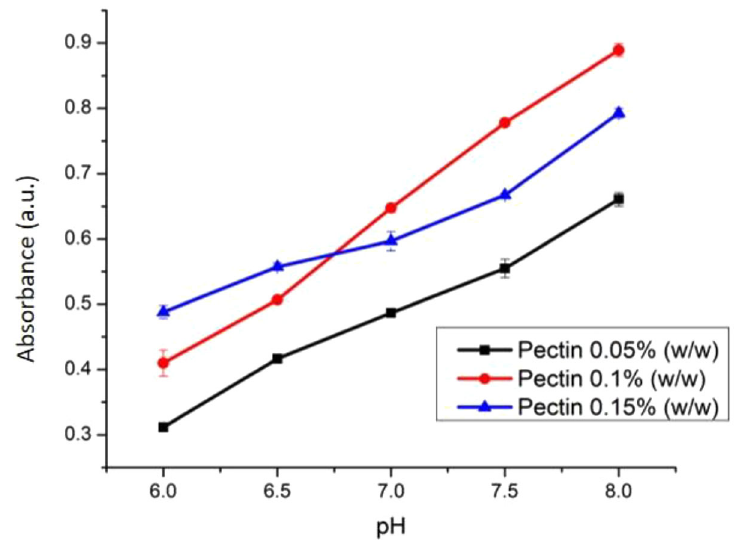
Figure 9. Effect of pectin weight towards the sensitivity of optical pH